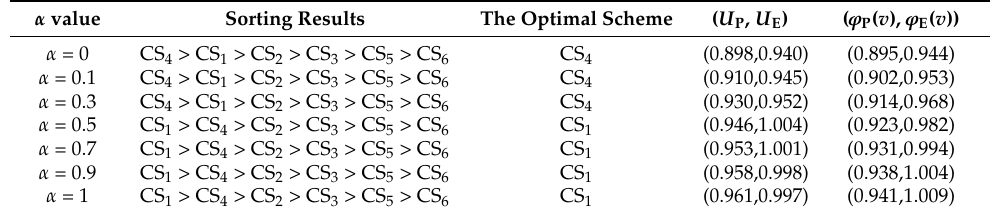
Table 11. The sorting results of the scheme under different α